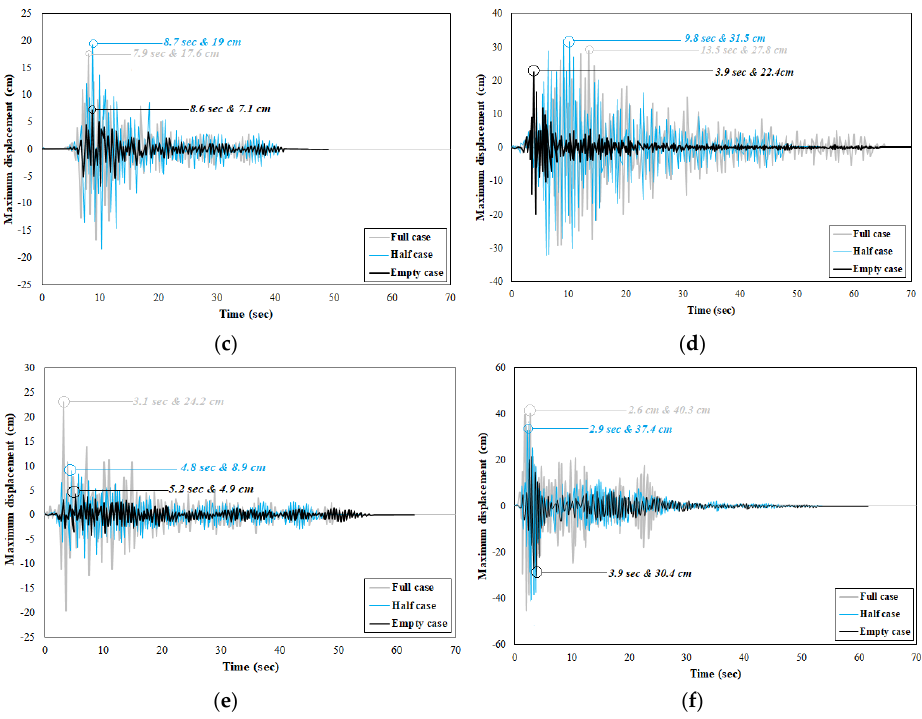
Figure 15. Time history of maximum displacement under various near ‐ fault ground motions: ( a ) Imperial Valley, ( b ) Kobe, ( c ) Kocaeli, ( d ) Loma Prieta, ( e ) Northridge, and ( f ) El Centro .